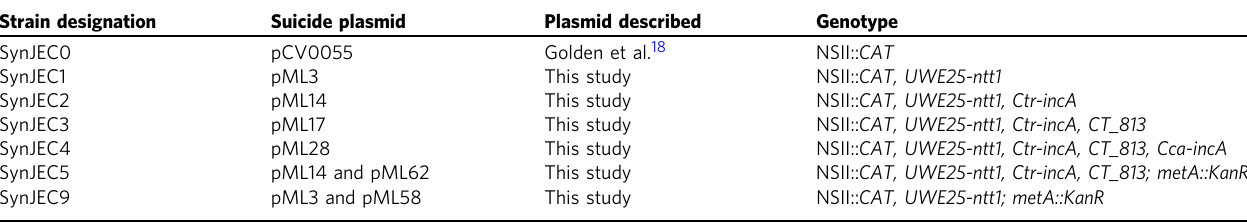
Note: See Supplementary Fig. 1 and Supplementary Table 3 for detailed plasmid